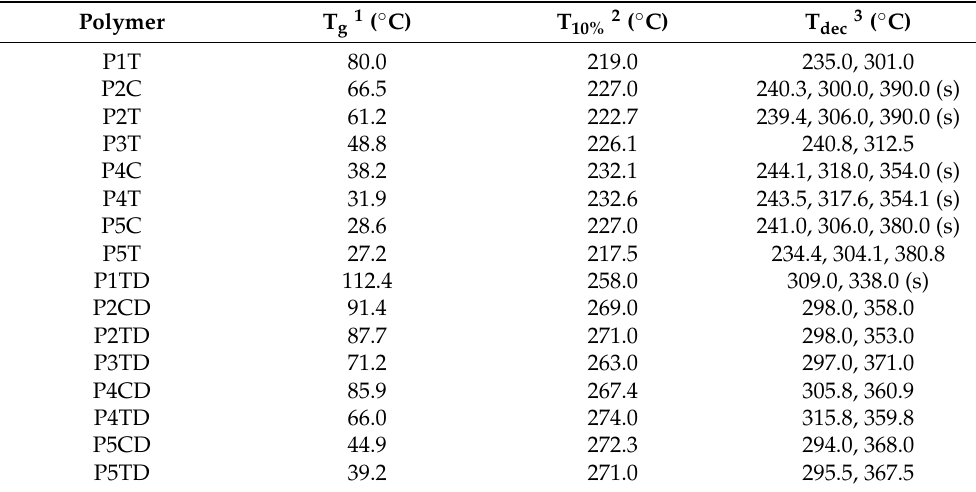
Table 2. Thermal analysis data of N -Boc-protected and deprotected polytriazoles.